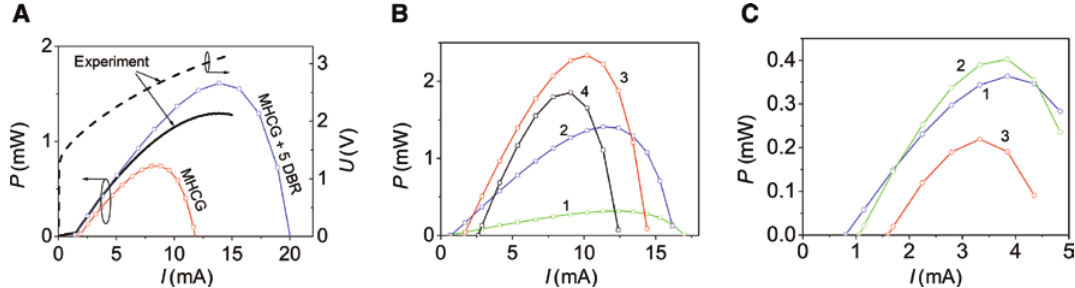
Figure 11: Emission characteristics of (A) measured and simulated M-D VCSELs in TM configuration, (B) simulated M-D VCSELs and (C) simulated M-M